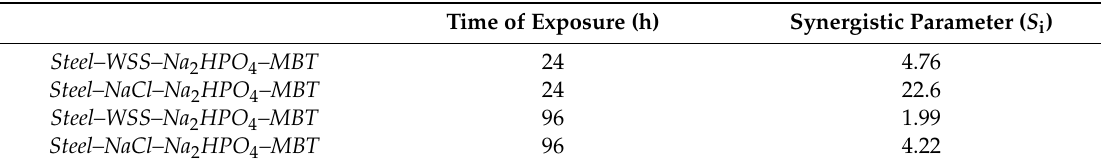
Table 5. Tabulated values of the synergistic parameter ( S i ) calculated using Equation